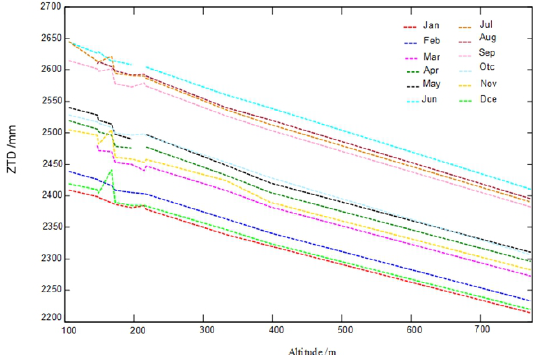
Figure 3 Variations of Monthly Average ZTD with Station